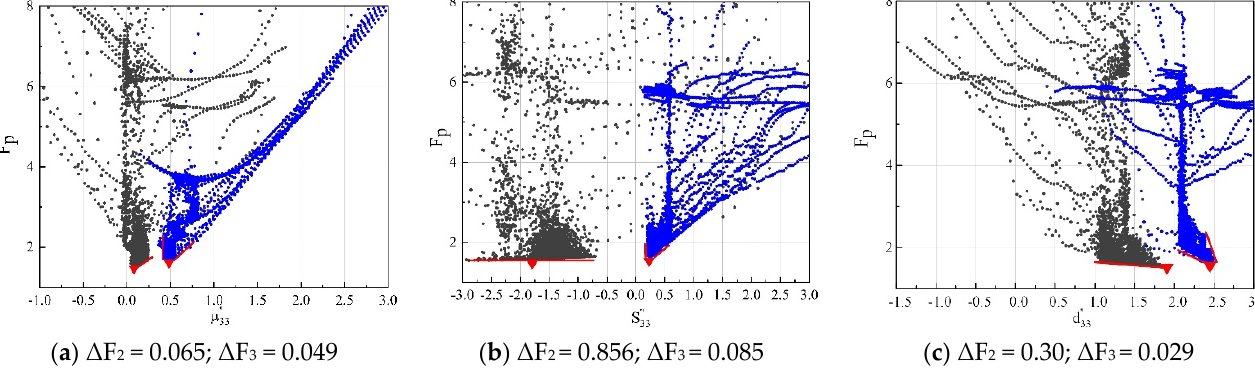
Figure 12. Sensitivities of three imaginary parts in Method 2 (the gray spots) and Method 3 (the blue spots). Δ F 2 and Δ F 3 are used to quantify the sensitivity of each parameter in Methods 2 and 3, respectively.